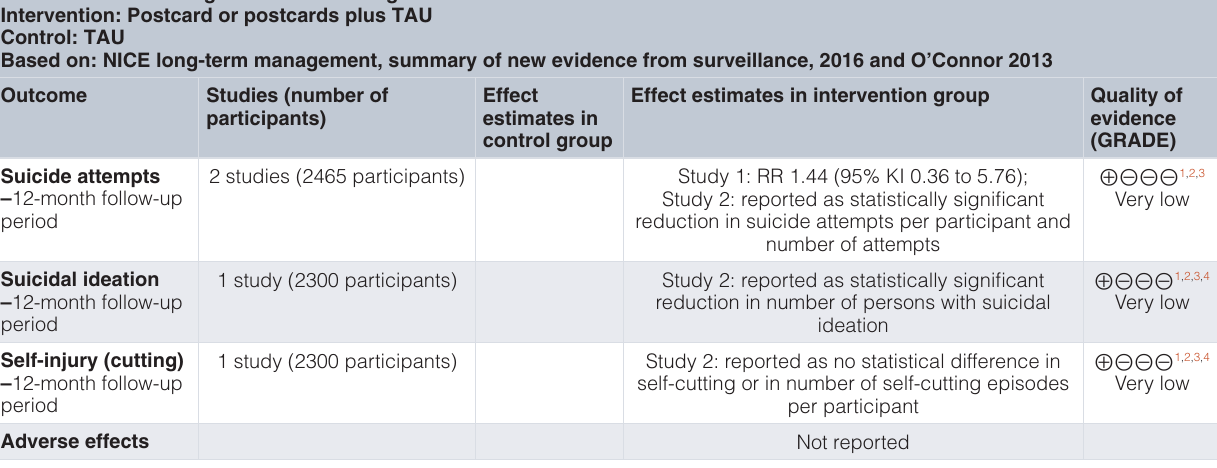
Table 16. GRADE-assessment: Interventions for existing self-harm: postcards versus treatment as usual (TAU). Population: Adolescents and young adults, 12 to 24-year olds, admitted to hospital after self-poisoning and/or a history of suicide threats, ideation, attempts, and/or deliberate self-harm who did not meet entry criteria for service, because they either were not unwell enough or were receiving treatment elsewhere Intervention: Postcard or postcards plus TAU